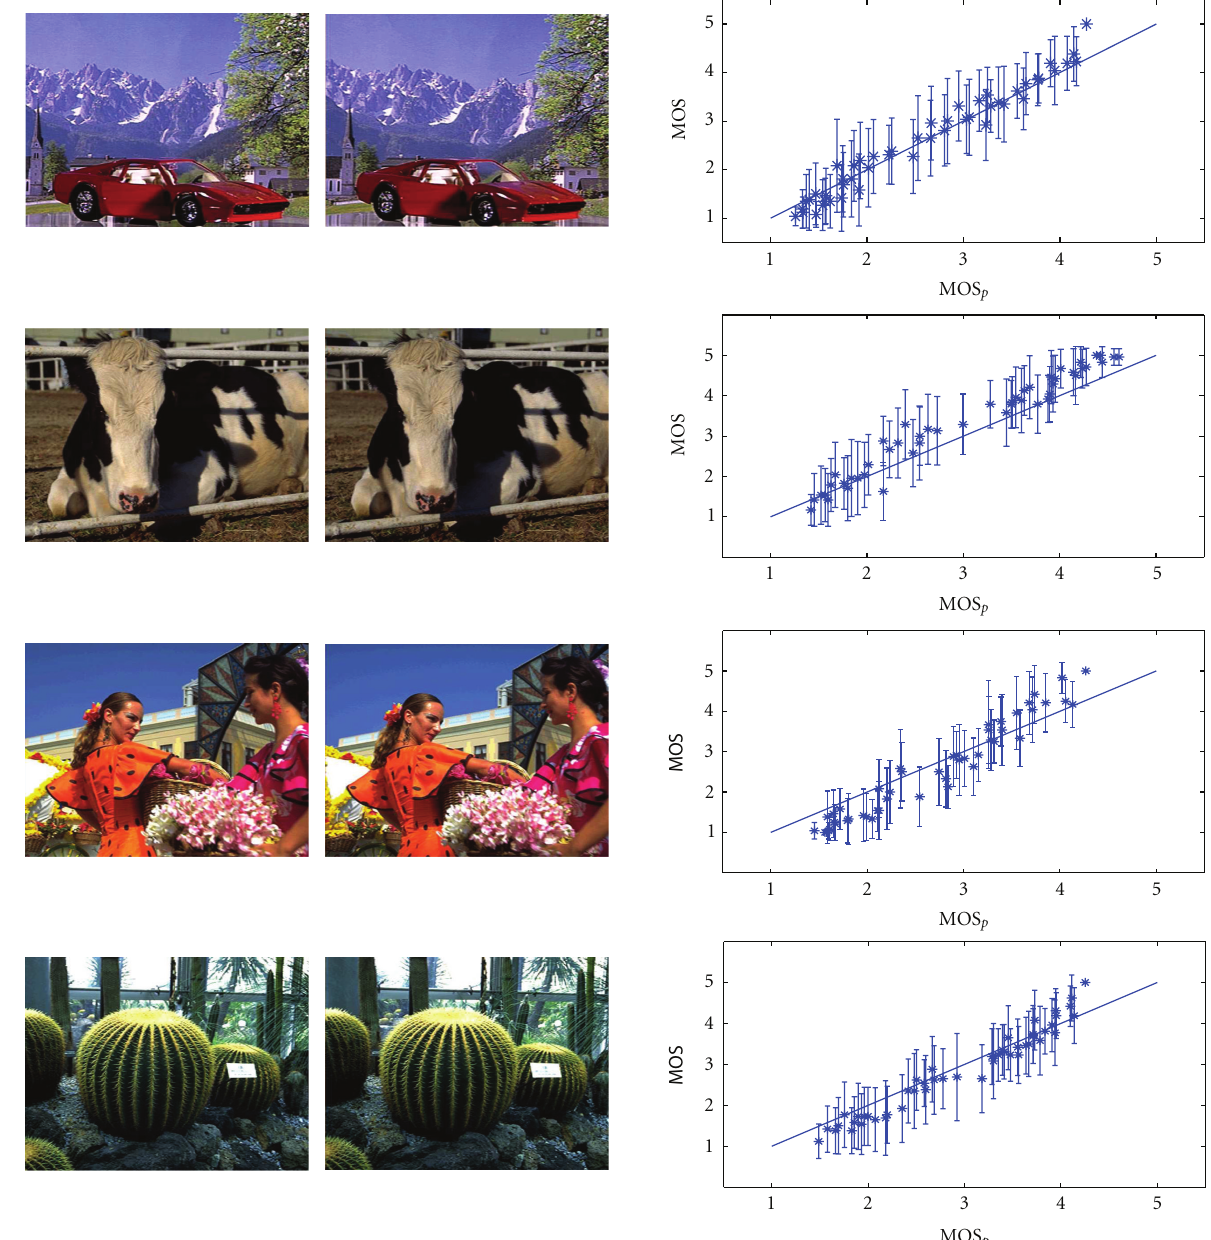
Figure 16: The MOS p performances on texture variety of stereo pairs over the quality range. The predictions points ∗ and ± 2 standard deviation intervals are shown for each stereo